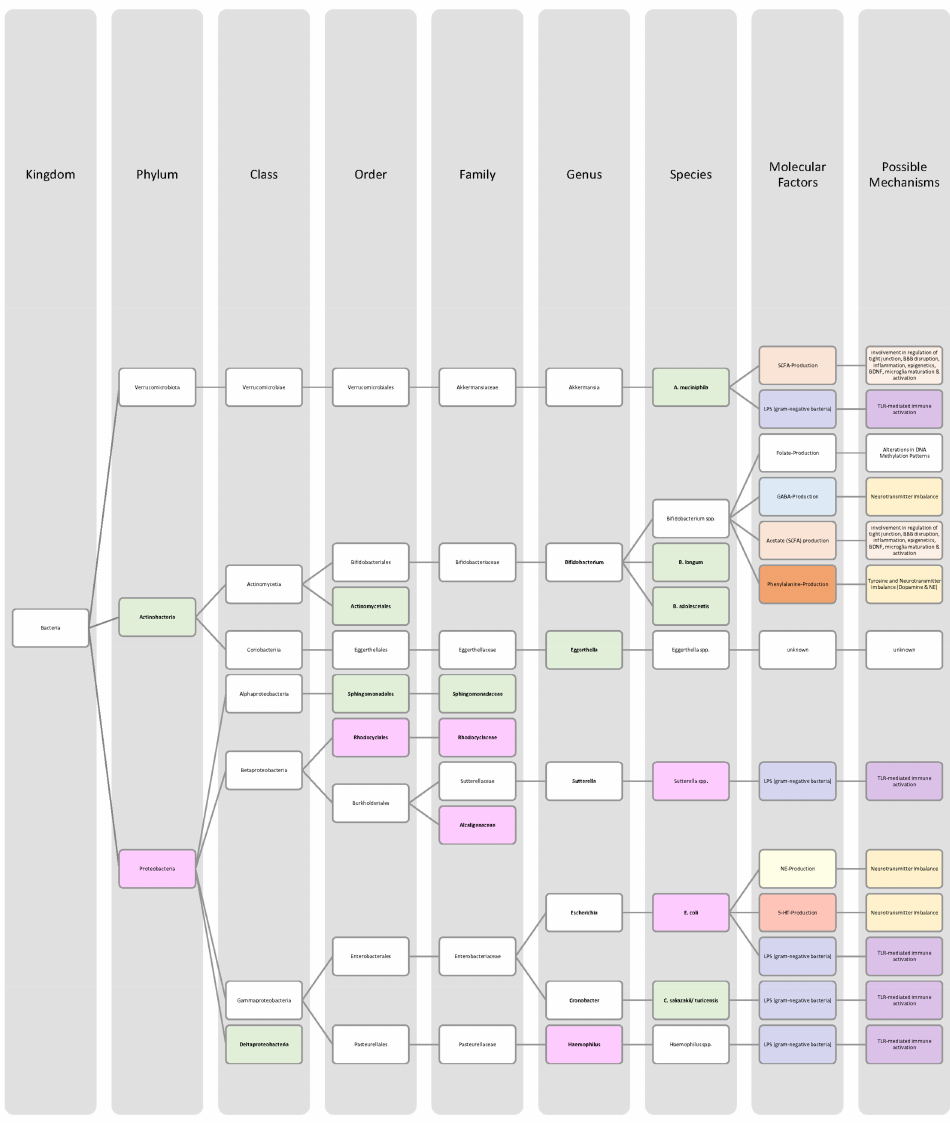
Figure 6. Part 2 of visual representation of the changes in microbiota composition in schizophrenia patients from Table 4. For Figures 5 and 6: The pedigree design highlights the taxonomic classification of the dysbiotic bacteria. Light green cells stand for an increase and the light red cells for a decrease, respectively. Significant changes are shown in bold letters ( p < 0.05). White cells indicate that no changes were reported or, in the case of Bifidobacterium, both significant increases and decreases were found. The last two columns contain additional, non-exhaustive information on how the bacteria